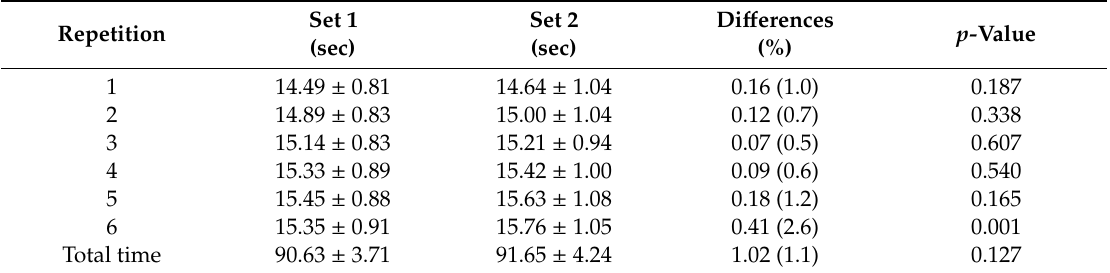
Table 2. Time scores in Sets 1 and 2 of the Ajax Shuttle Test (AST) and their di ff erences.